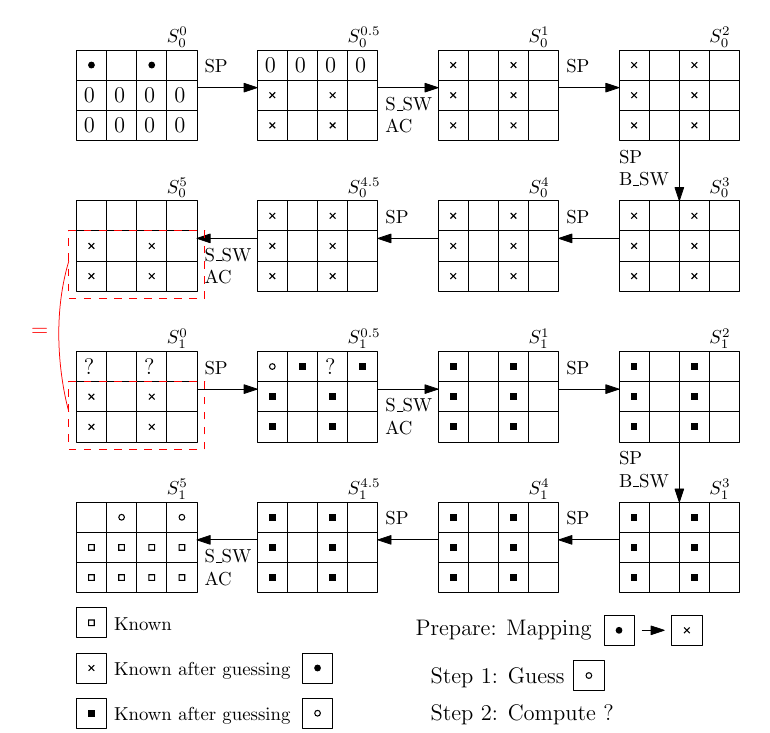
Figure 8: Illustration of the preimage attack on 5-round